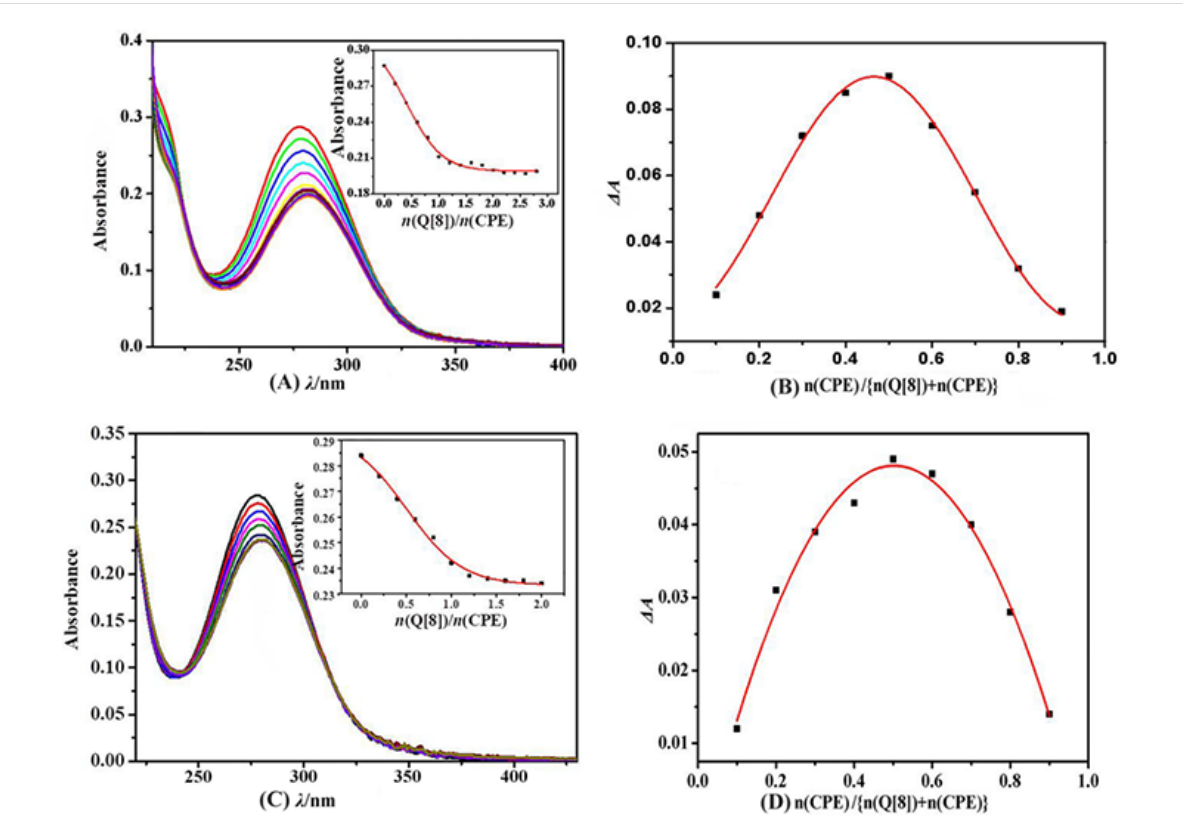
Figure 3: UV–vis absorption spectra of CPE with Q[8] in aqueous solution (A) or hydrochloric acid solution (C) and UV–vis Job’s plot of Δ A against n (Q[8])/[ n (Q[8]) + n (CPE)] at 278 nm (B, D). c (CPE) = 30 μ mol/L, ( c (Q[8]) / c (CPE) ) = 0, 0.2, 0.4, 0.6, 0.8, 1.0; ··· 2.8), insets in (A, C) are the plot of absor- bances at 278 nm of